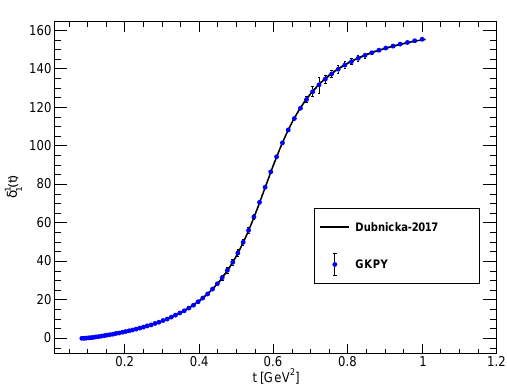
( t ) data. Solid line represents our optimal fit of data with 1